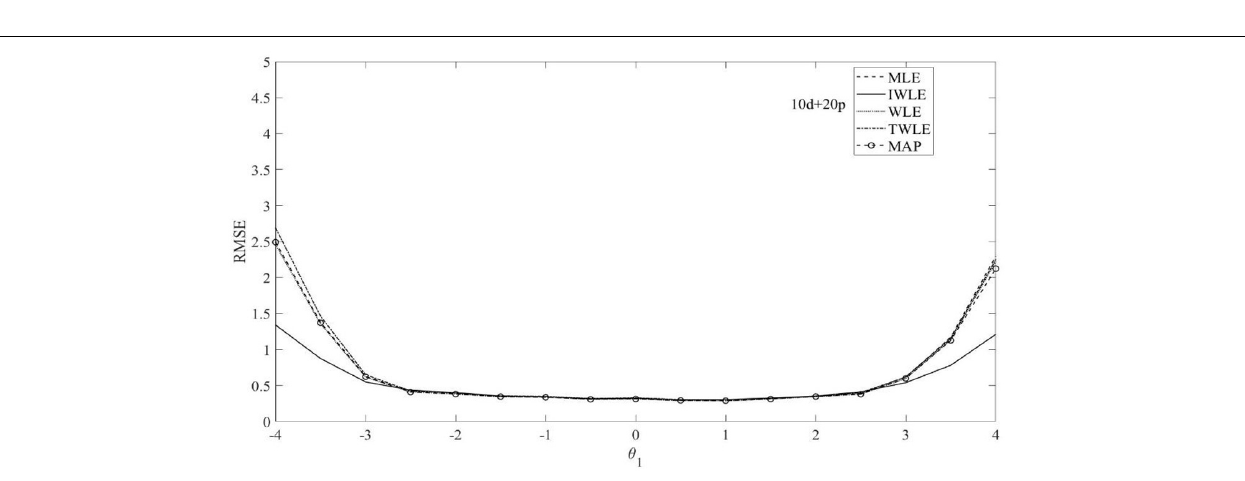
FIGURE 5 | RMSE of the five θ 1 estimation methods MLE, MAP, IWLE, WLE, and TWLE for 10d+20p.